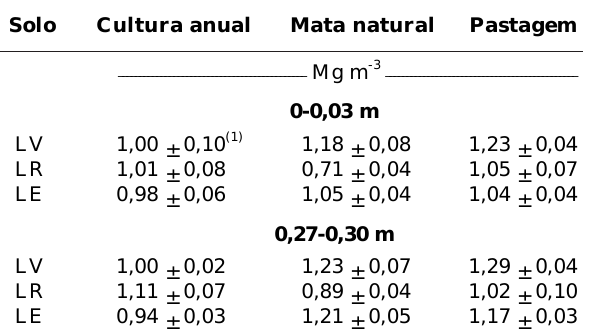
Quadro 2. Densidade do solo inicial (Ds ensaio de compressão para os três solos